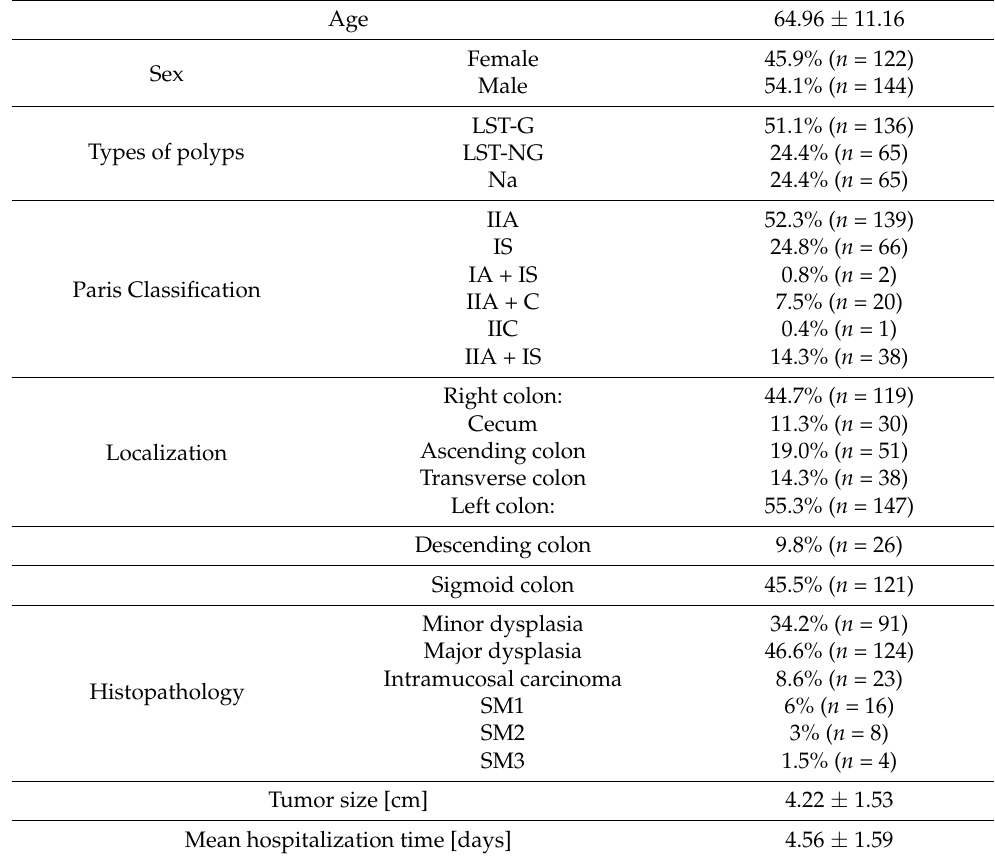
Table 1. Baseline characteristics of the study